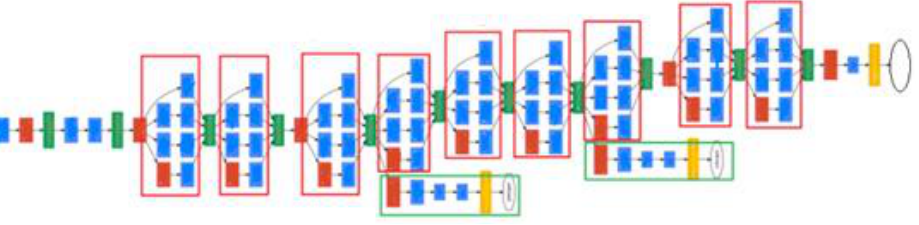
Figure 6. GoogLeNet structure.